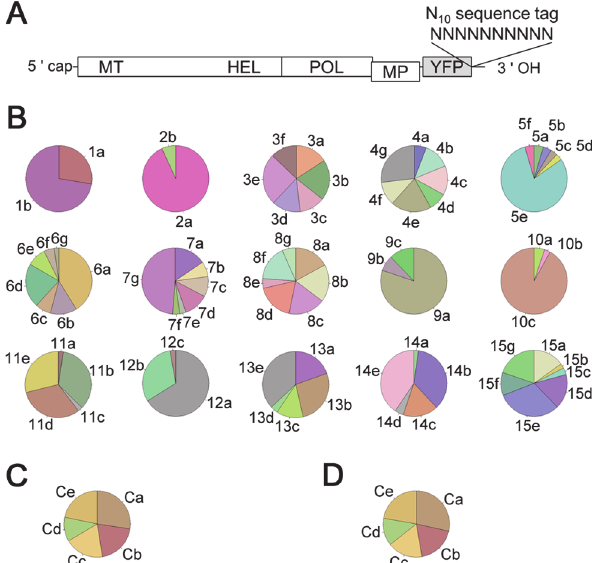
Fig 4. Stochastic variation in the numbers of founders and stochastic inequality in progeny accumulation in vivo. (A) A ToMV variant library tagged with random 10-nucleotide sequences. (B) The frequencies of tag sequences identified from each cell sample. Each pie chart corresponds to a cell sample. A tag ID code (e.g., “ 1a ” and “ 1b ” ) was assigned to each tag sequence. The tag sequences with the tag ID codes and their detection frequencies are shown in S1 Table. The color codes were assigned automatically according to the identified tag sequences. (C,D) Control experiments. In control 1, a mixture containing equal amounts of five differently tagged viral RNAs was used as a template for RT-PCR (C). In control 2, RNA extracted from 1 × 10 5 protoplasts inoculated with a mixture containing equal amounts of the five RNAs and cultured for 24 h was used as the template